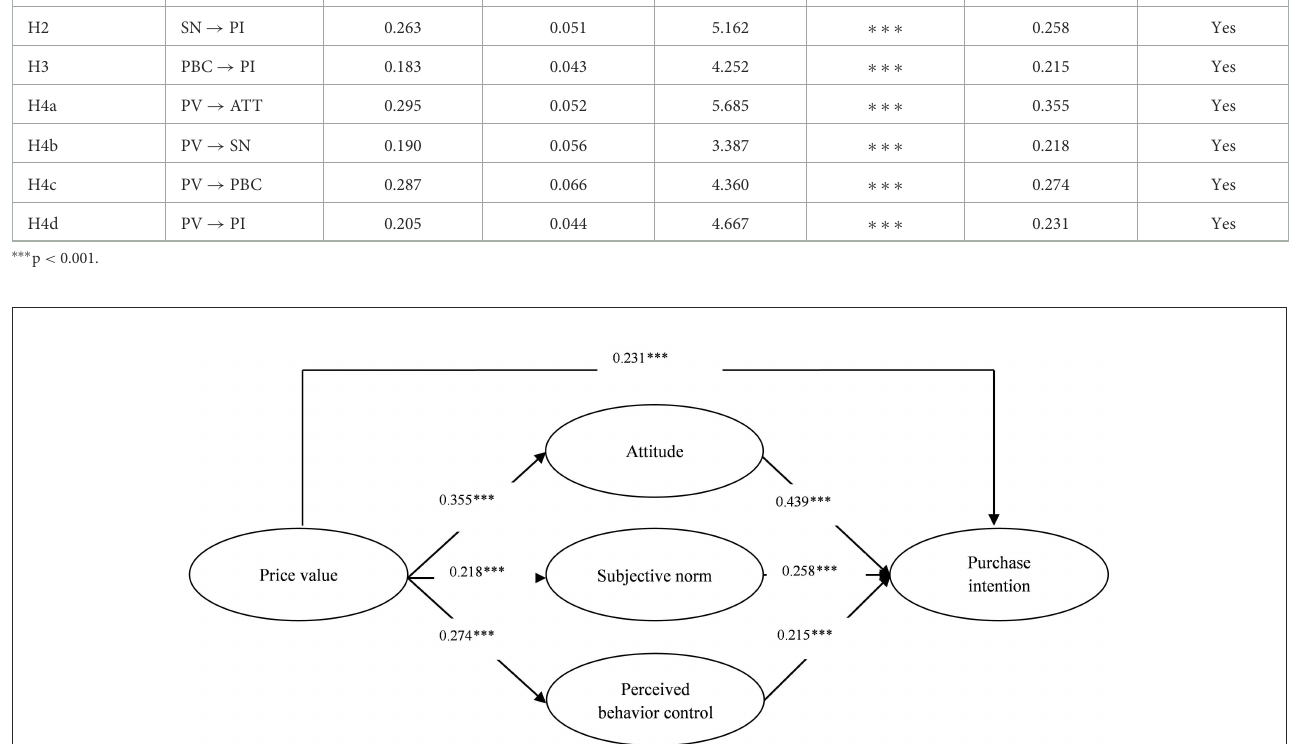
FIGURE2 Analysis results of structural model. *** p < 0.001; Model fit indices: χ 2 / df = 2.13, GFI = 0.94, AGFI = 0.91, RMSEA = 0.05; PNFI = 0.75, PGFI = 0.67, CFI = 0.96, NFI = 0.93, IFI = 0.96; R 2 for attitude = 0.14, R 2 for subjective norm = 0.07, R 2 for perceived behavior control = 0.10, R 2 for purchase intention =